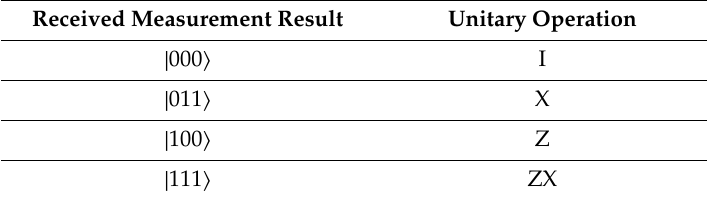
Table 1. The relations between Alice’s and Bob’s measurement results and unitary operations.